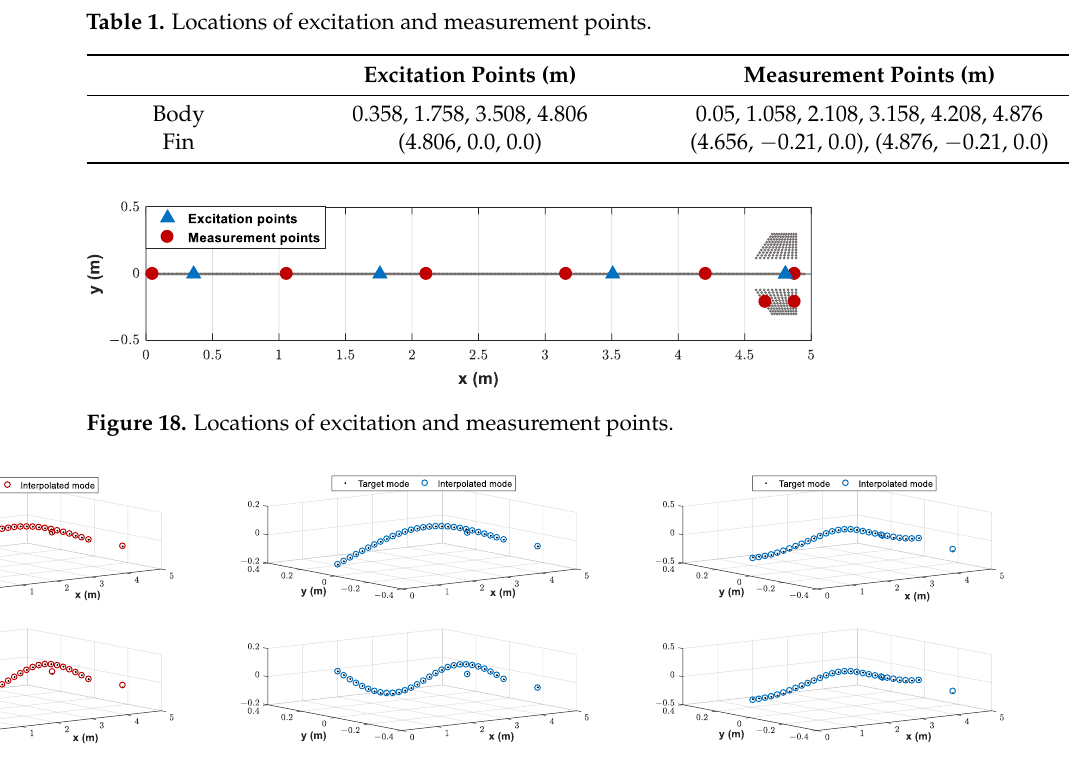
Figure 19. Comparison of target modes and interpolated modes. ( a ) Φ ( c ) Φ (cid:48) c and (cid:101) Φ (cid:48) c